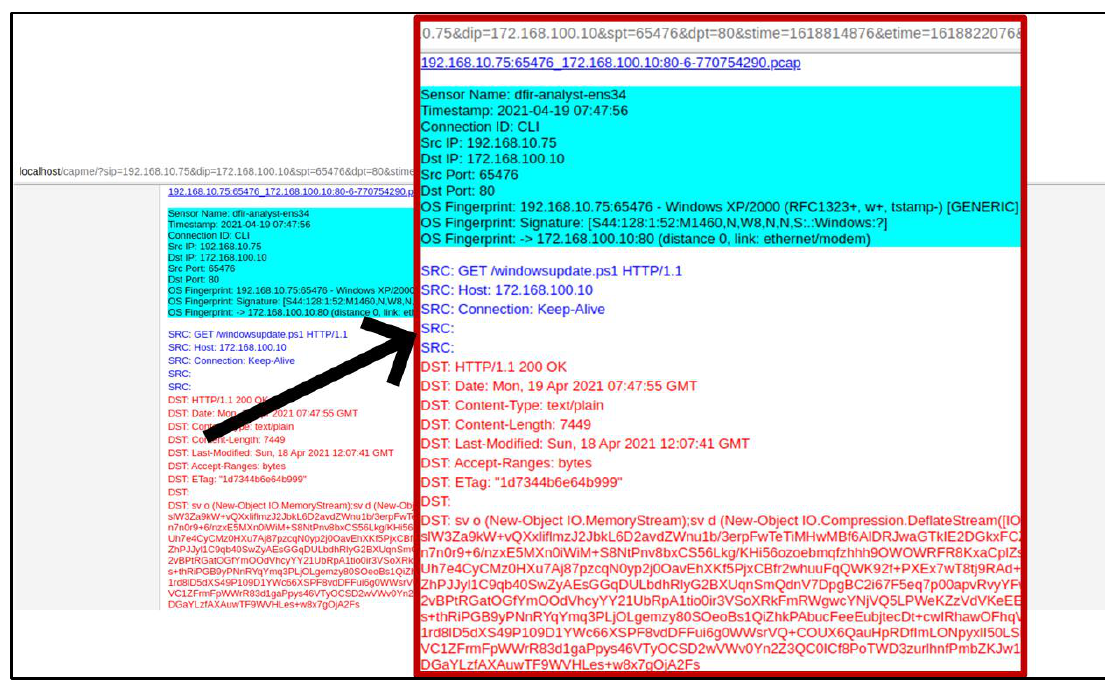
Figure 8. CapME transcript showing the PowerShell stager.